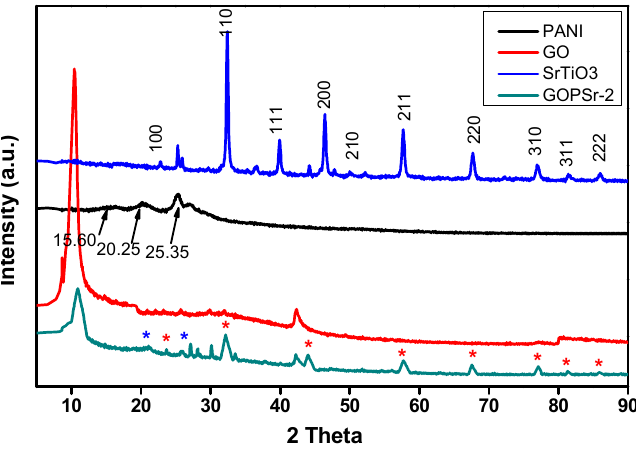
Figure 4. XRD pattern of PANI, GO, SrTiO3, and GOPSr-2.